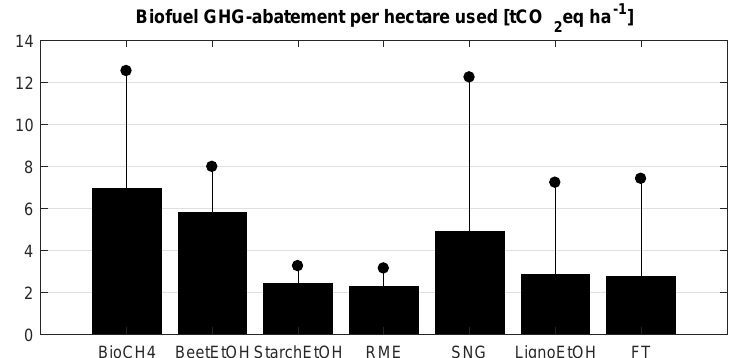
Figure 5. Biofuel GHG abatement per hectare in the base case with medium yields for all crops. The bar shows the initial GHG abatement, whereas the whisker extends to the GHG abatement in the last